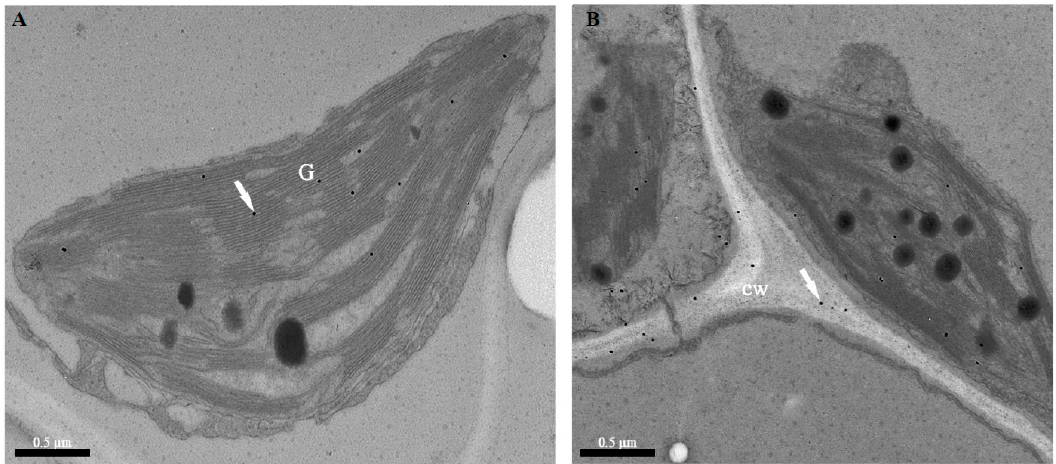
Figure 2. TEM immunolocalization of TGase in cucumber leaf chloroplasts using the monoclonal antibody (1:1000). ( A ) Signal in the granary of the chloroplasts. ( B ) Signal in the cell well. G, grana; cw, cell wall.